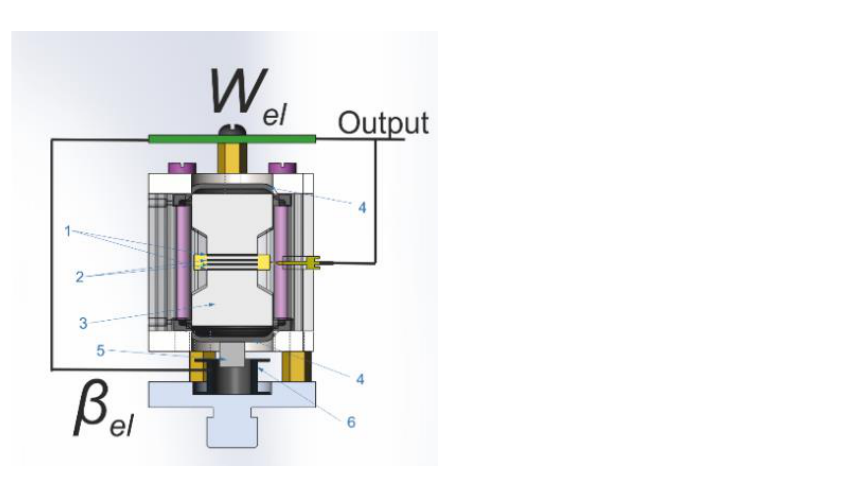
Figure 1. Schematic representation of an electrochemical sensor with an electromagnetic power feedback system: 1—anodes; 2—cathodes; 3—electrolyte; 4—membranes; 5—magnet; 6—electromagnetic coil. The permissible ranges of operating temperatures of such sensors are determined by the properties of the working fluid used [22]. The working fluid is an electrolyte with the addition of active molecules, which undergo a dissociation process on the electrodes and transfer a charge. The main parameters of the electrolyte are the same: the coefficient of viscosity; the diffusion coefficient, which determines the rate of delivery of ions to the electrode; the concentration of the active component; the concentration of the background electrolyte; and the solvent, on the basis of which the electrolyte is created, which affects both the solubility of the background electrolyte and the temperatures of phase transitions: freezing and boiling. From [21], for a seismic sensor, the mechanical signal conversion function can be represented as follows: